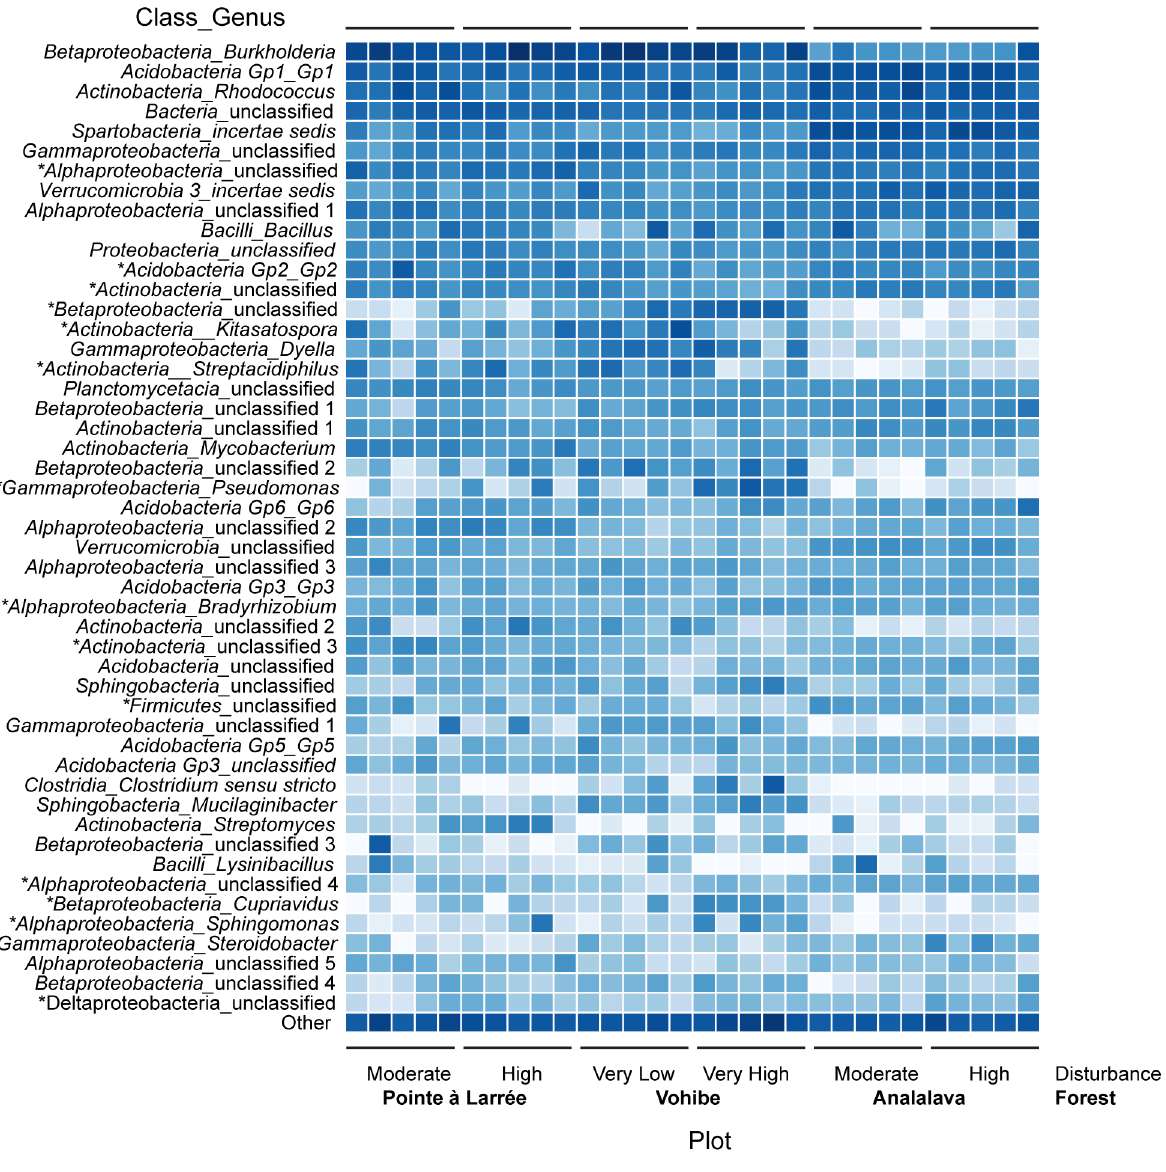
Table 3. Bacterial diversity statistics a calculated at the OTU (3%) level.